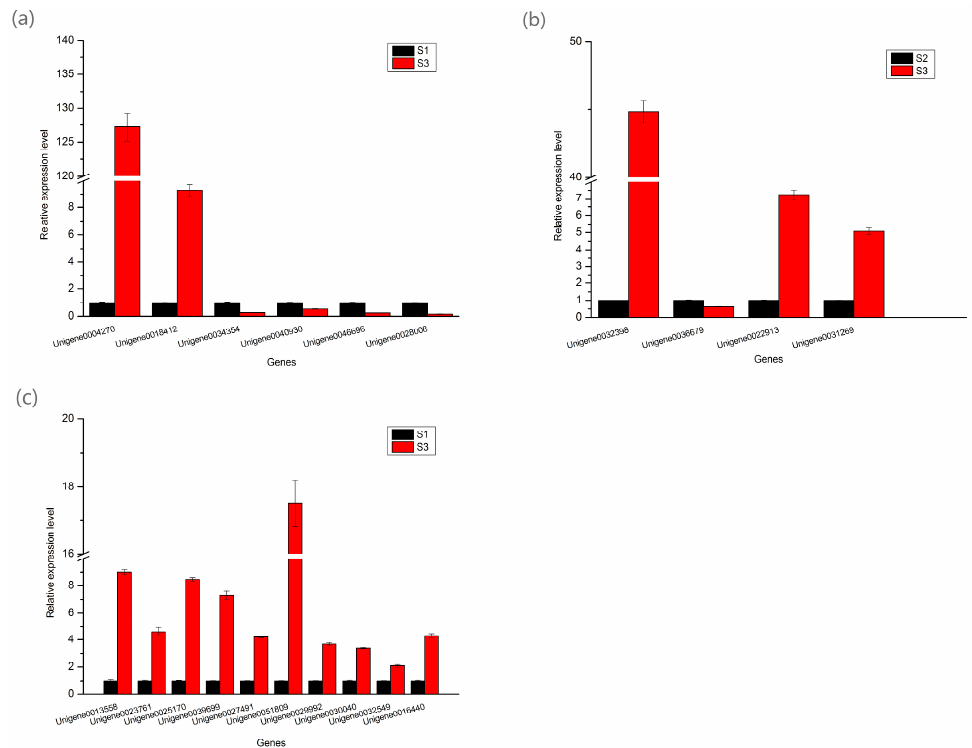
Figure 4. The expression patterns of DEGs involved in anthocyanin ( a ), chlorophyll ( b ), and carotenoid ( c ) biosynthesis revealed by real-time quantitative PCR.